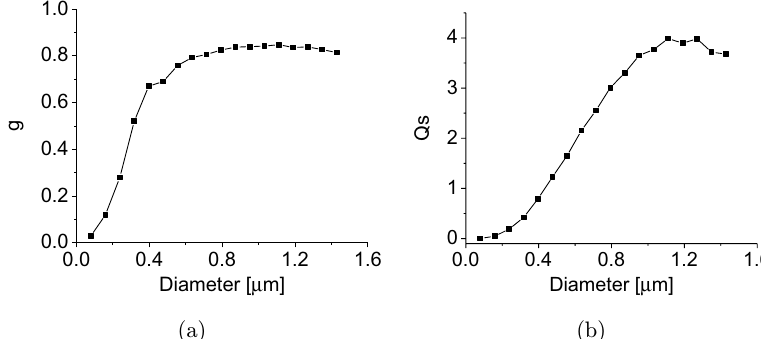
Fig. 1. g -factor (a), and scattering e±ciency factor Q s (b), calculated for individual ZnO particles of di®erent sizes used for phantom fabrication. The calculations are based on the Mie theory of scattering. Theoretical and experimental values of g (cid:2) correspond to the actual ZnO powder used for phantom fabrication and the size distribution is taken into account of the particles: g (cid:2) ¼ 0 : 76 (theory), g (cid:2) ¼ 0 : 80 (experiment).